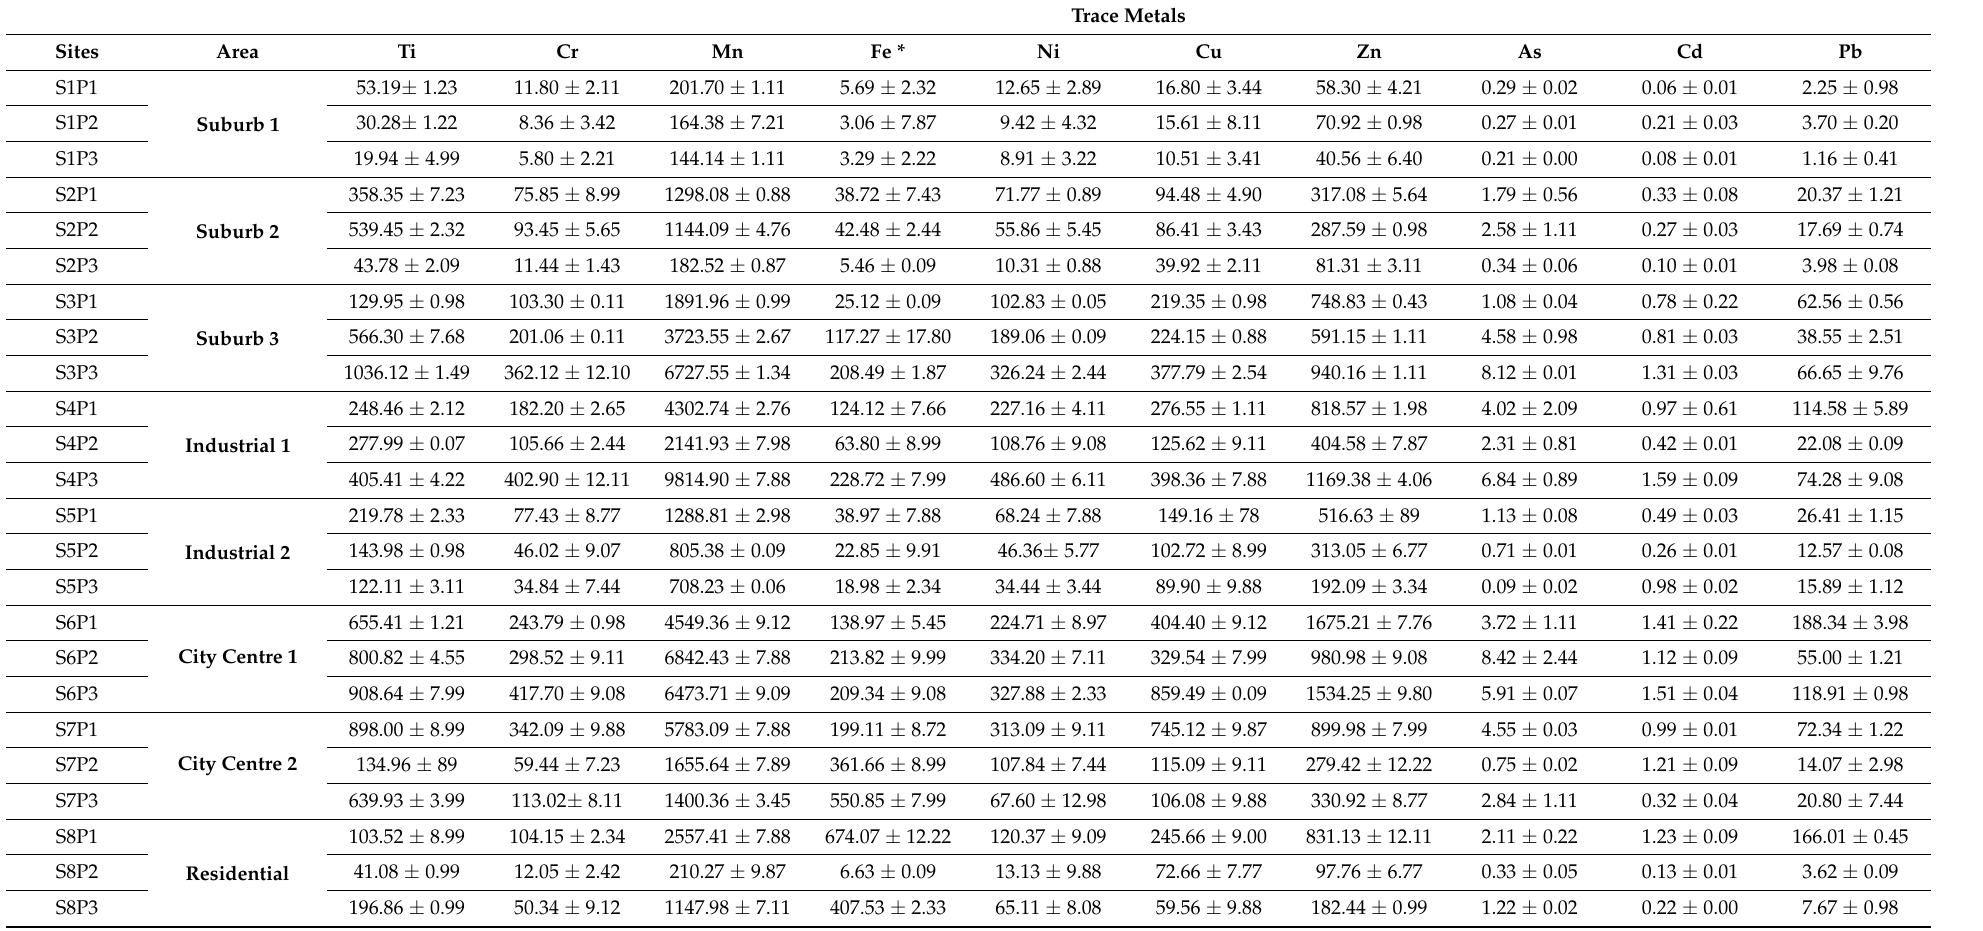
Table 3. Concentrations of trace elements ( µ g/g and mg/g *) in soils collected from different areas in Pretoria.